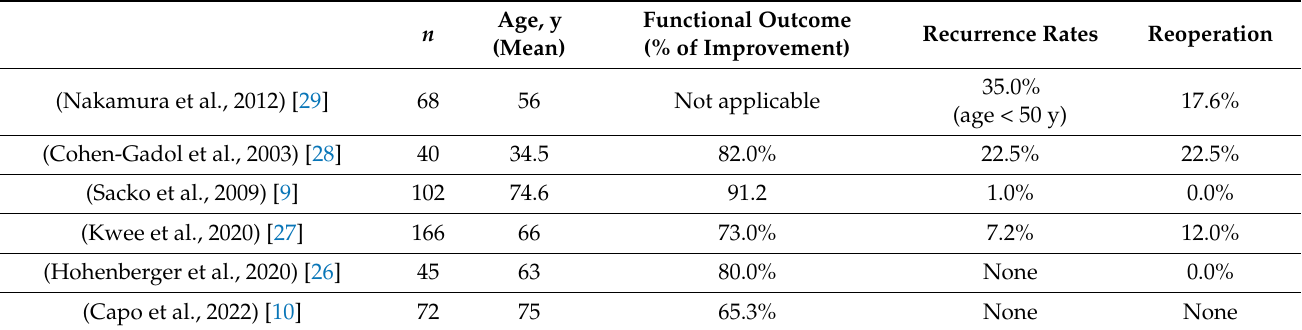
Table 6. Overview of recent studies on spinal meningioma with a special focus on patients’ outcomes with respect to the patient’s